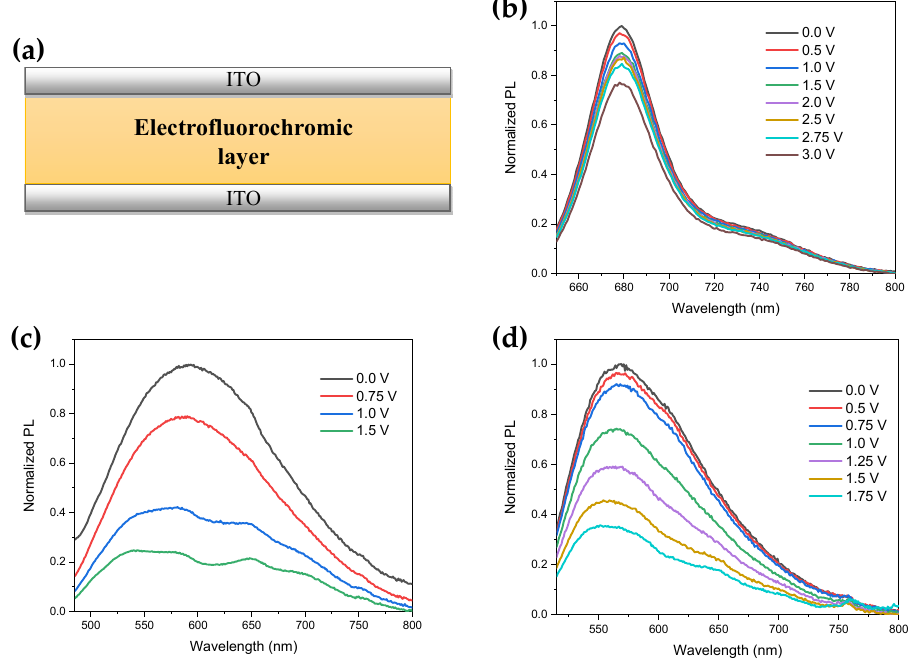
Figure 2. Electrofluorochromism of ITO/EFC/ITO devices, schematized in panel ( a ), containing the ( b ) DIBSQ/FC; ( c ) TSQ1/EV ( d ) TSQ2/EV systems. Film thickness = 15 μ m.